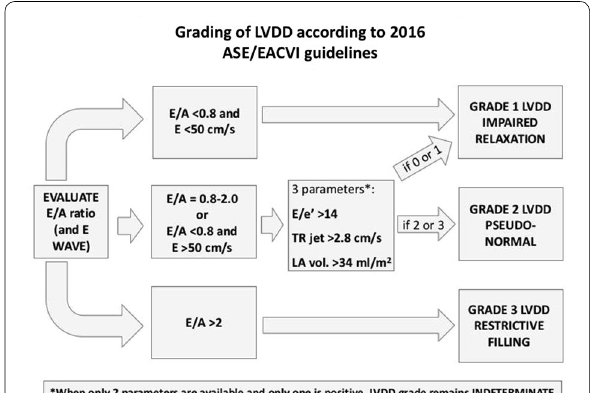
Fig. 2 Algorithm for grading of left ventricular diastolic dysfunction (LVDD) in outpatients according to the 2016 American Society of Echocardiography and European Association of Cardiovascular Imaging (ASE/EACVI)